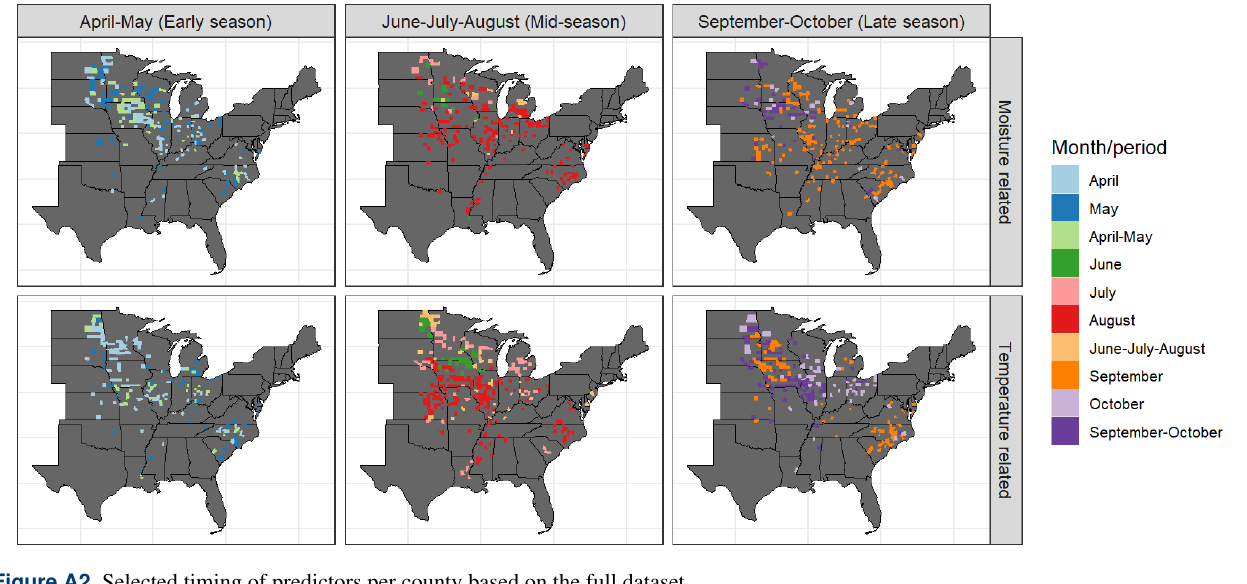
Figure A2. Selected timing of predictors per county based on the full dataset.